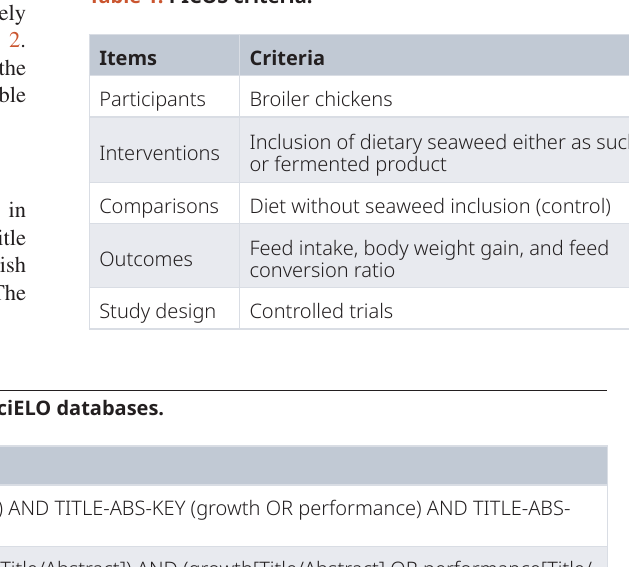
Table 1. PICOS criteria.